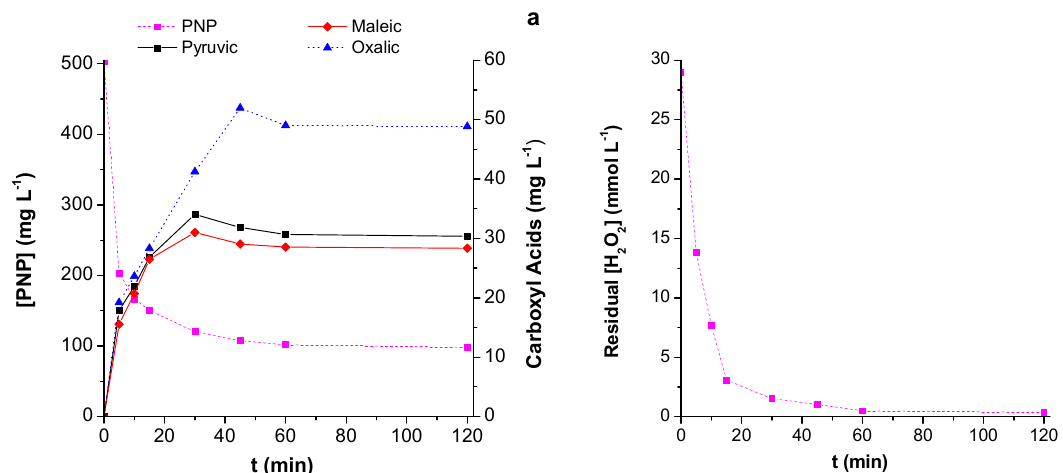
Figure 8. p -nitrophenol (PNP) and carboxylic acids concentration ( a ) and consumption of hydrogen peroxide ( b ) along Fenton reaction with Fe/XGM catalyst (pH = 3.0, T = 30 ◦ C, [Fe/XGM] = 0.25 g L − 1 , [H 2 O 2 ] = 29 mmol L − 1 , [PNP] = 3.6 mmol L − 1 and H 2 O 2 :PNP molar ratio =